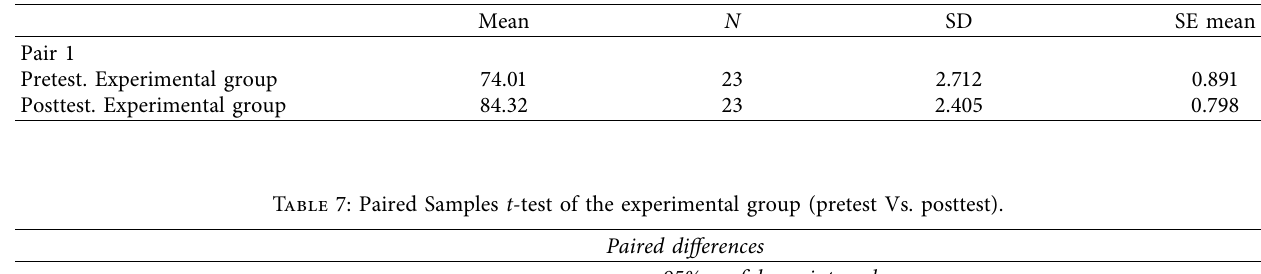
Table 6: Paired Samples t -test descriptive results (experimental